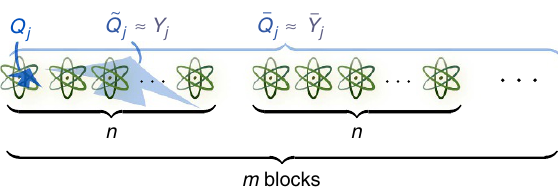
Figure 2 | Noncommuting charges. We consider a thermodynamic system S that has conserved charges Q j . These Q j ’s might not commute with each other. The system occupies a thermal state whose form we derive. The derivation involves an approximate microcanonical state of a large system that contains the system of interest. Consider a block of n copies of S . Most copies act, jointly, similarly to a bath for the copy of interest. We define ~ Q